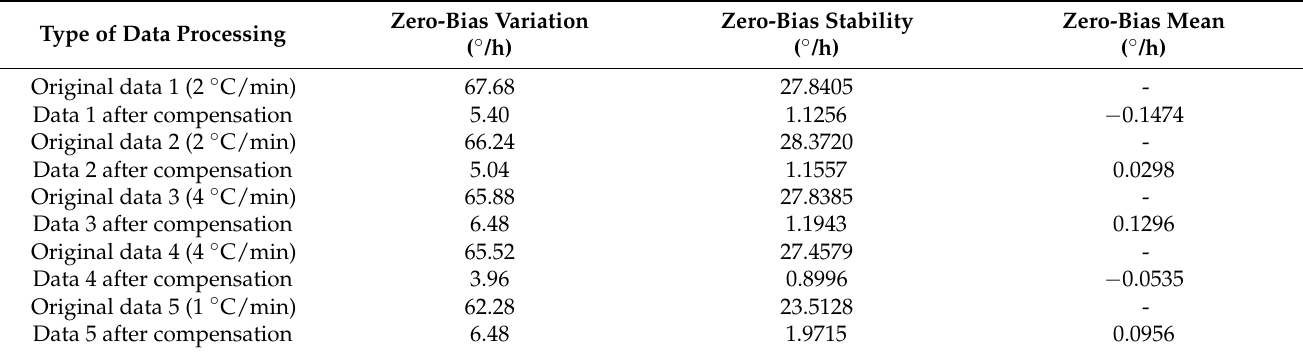
Figure 7. Relationship between gyroscope driving frequency and zero bias under different tempera- ture change rate conditions. ( a ) Before compensation. ( b ) After compensation. Table 2. Comparison of the self-compensation effect of each group of data.